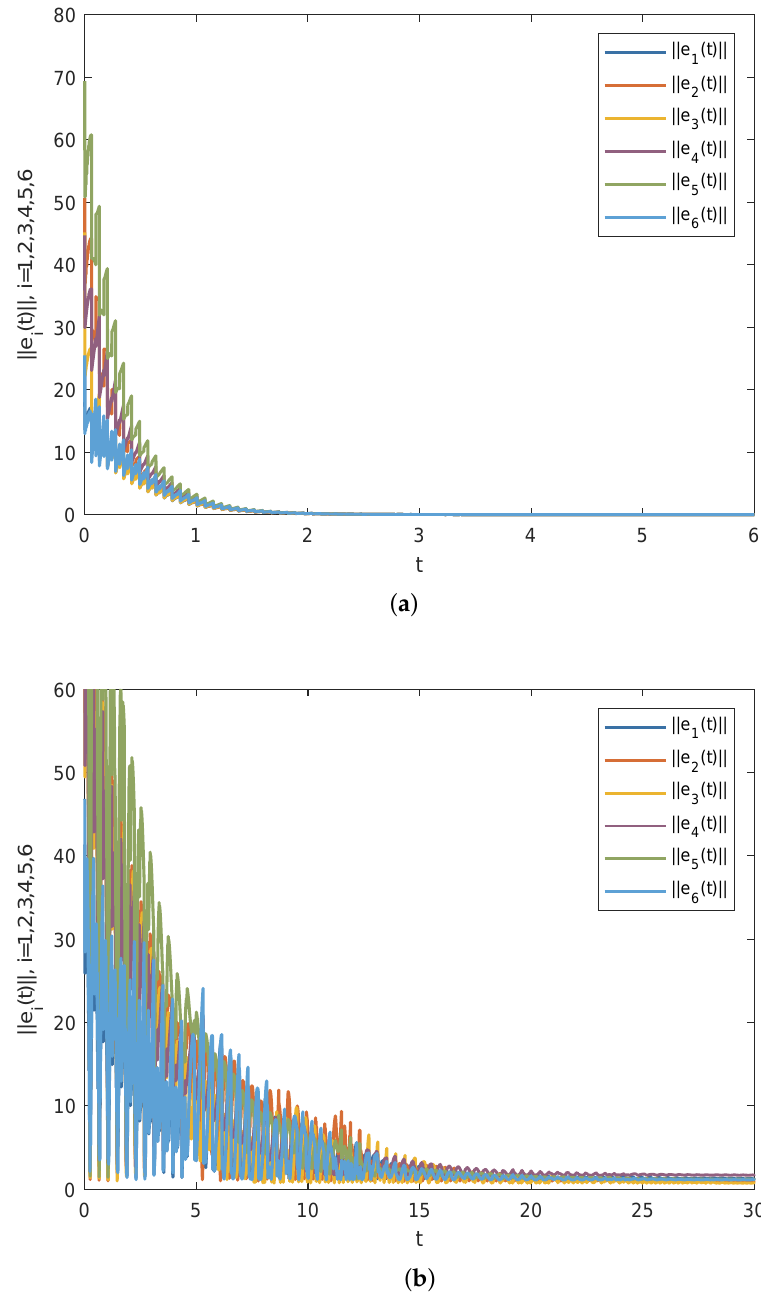
Figure 3. ( a ) Time evolution of (cid:107) e i ( t ) (cid:107) through the effective impulsive matrix M . One can see that synchronization errors (cid:107) e i ( t ) (cid:107) approach zero over time, which implies response network (23) achieves synchronization with drive network(22) in this case. ( b ) Time evolution of (cid:107) e i ( t ) (cid:107) under impulsive gain matrix M ∗ = M − 0.1 I . Since matrix M ∗ breaks the conditions of Corollary 2, one can see that (cid:107) e ( t ) (cid:107) cannot approach zero over time and the synchronization fails in this i